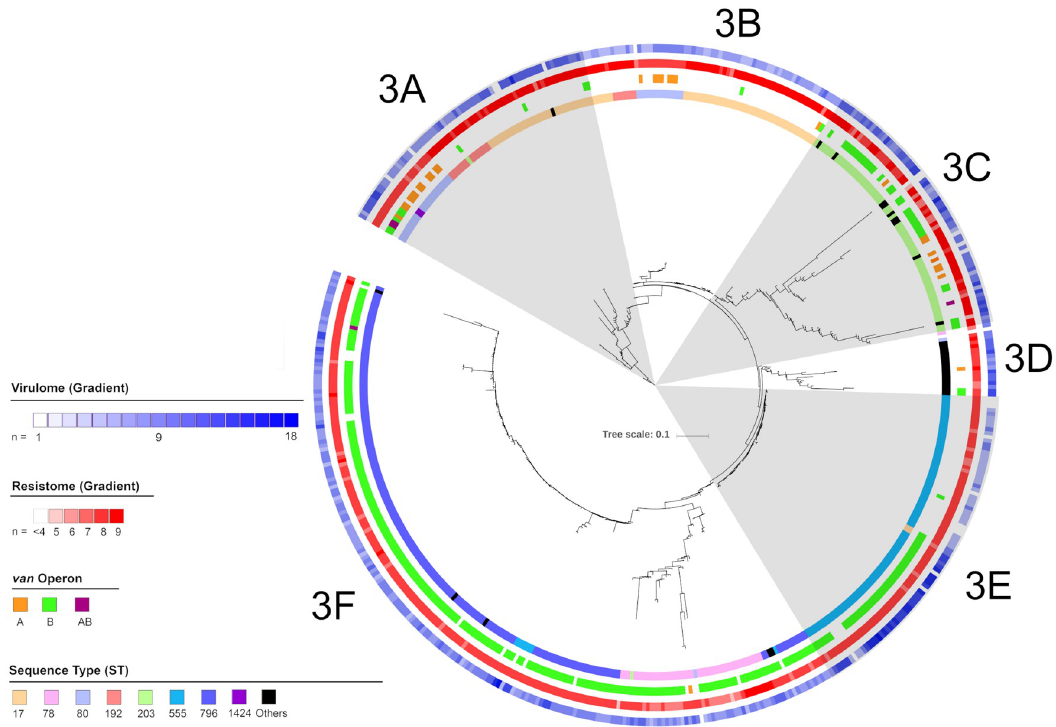
Fig 4. Maximum likelihood phylogenetic tree of isolates in cluster 3. From the outermost ring: Number of virulence factors, number of resistance genes not including the van operon, type of van operon and sequence types are highlighted as per legend.